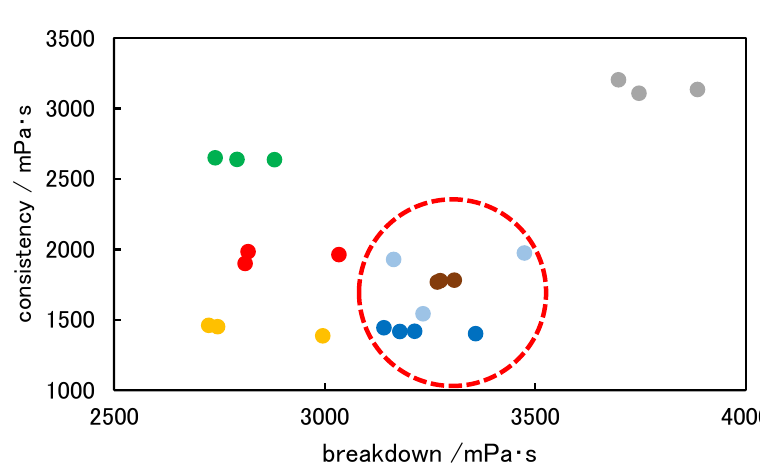
Figure 4. Relationship between the breakdown and consistency of raw rice candidates.